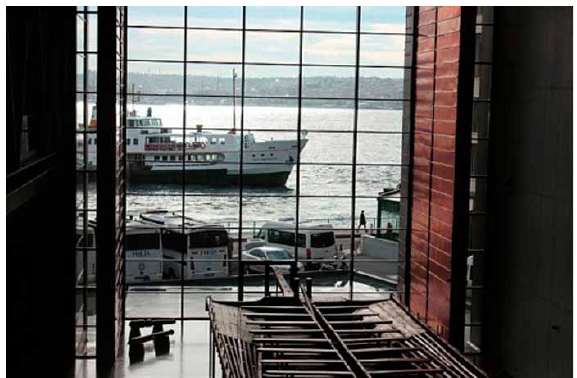
fig. 18. Istanbul naval Museum – interior